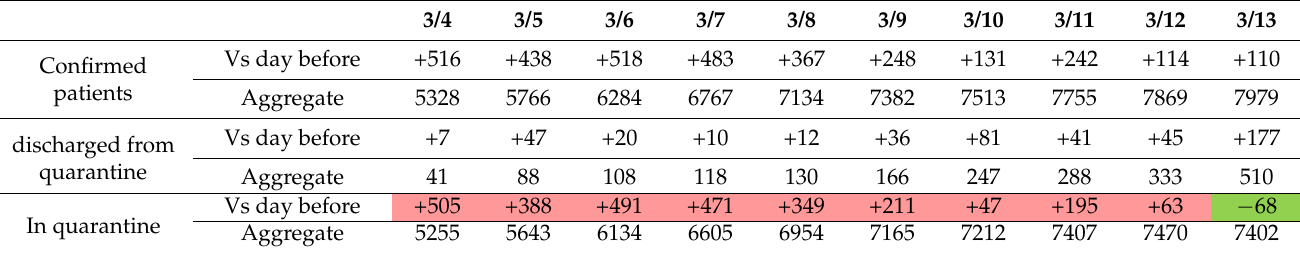
Table 1. COVID-19 Domestic Cases from March 4 to March 13 (in # of